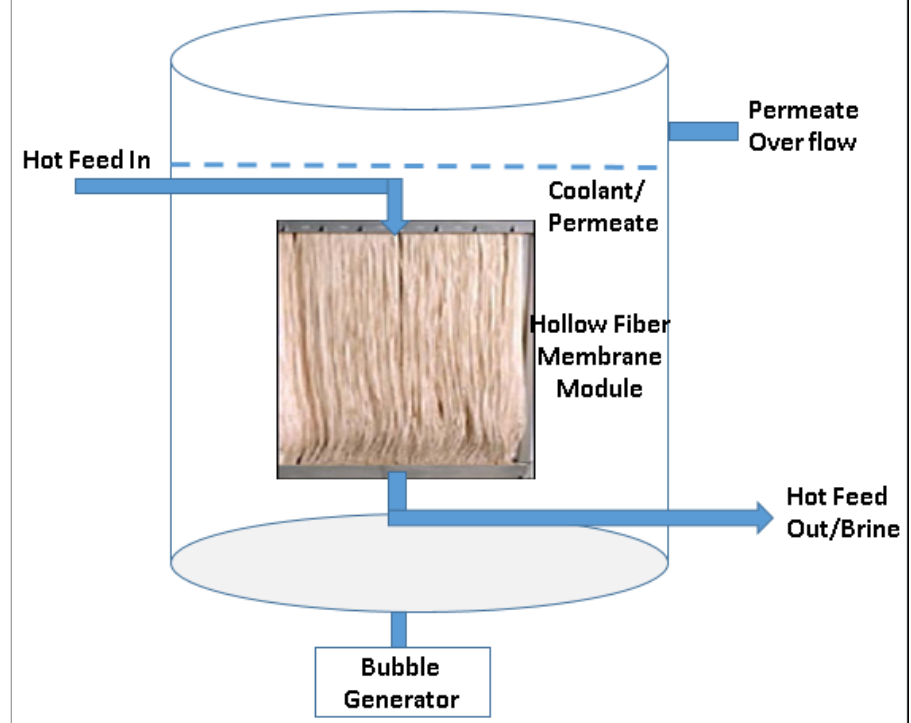
Figure 6. Schematic of Submerged membrane distillation (SMD) process. Julian and coworkers have reported an integrated submerged vacuum membrane distillation crystallization (SCMDC) system for the water recovery and cane sugar crys ‐ tallization. [94] They observed extremely low permeate flux due to the high degree of im ‐ purities in the feed solution. Choi and co ‐ workers have reported an integrated submerged membrane distillation—adsorption system for simultaneous water reclamation and Ru ‐ sources from the feed solution via the MD process integrated with the adsorption method.